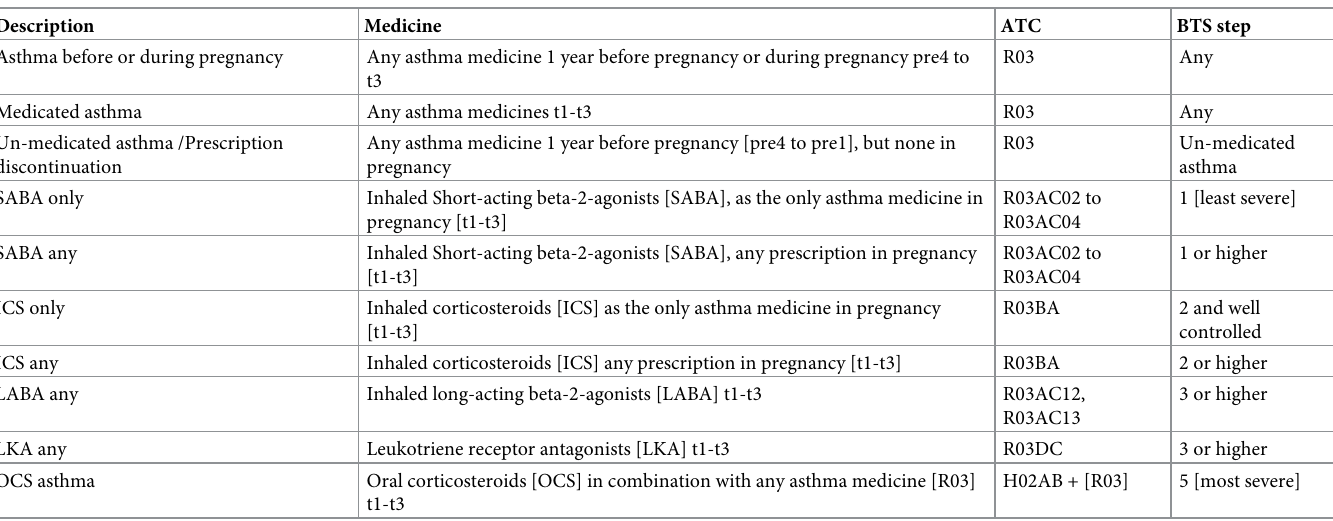
Table 1. Exposure